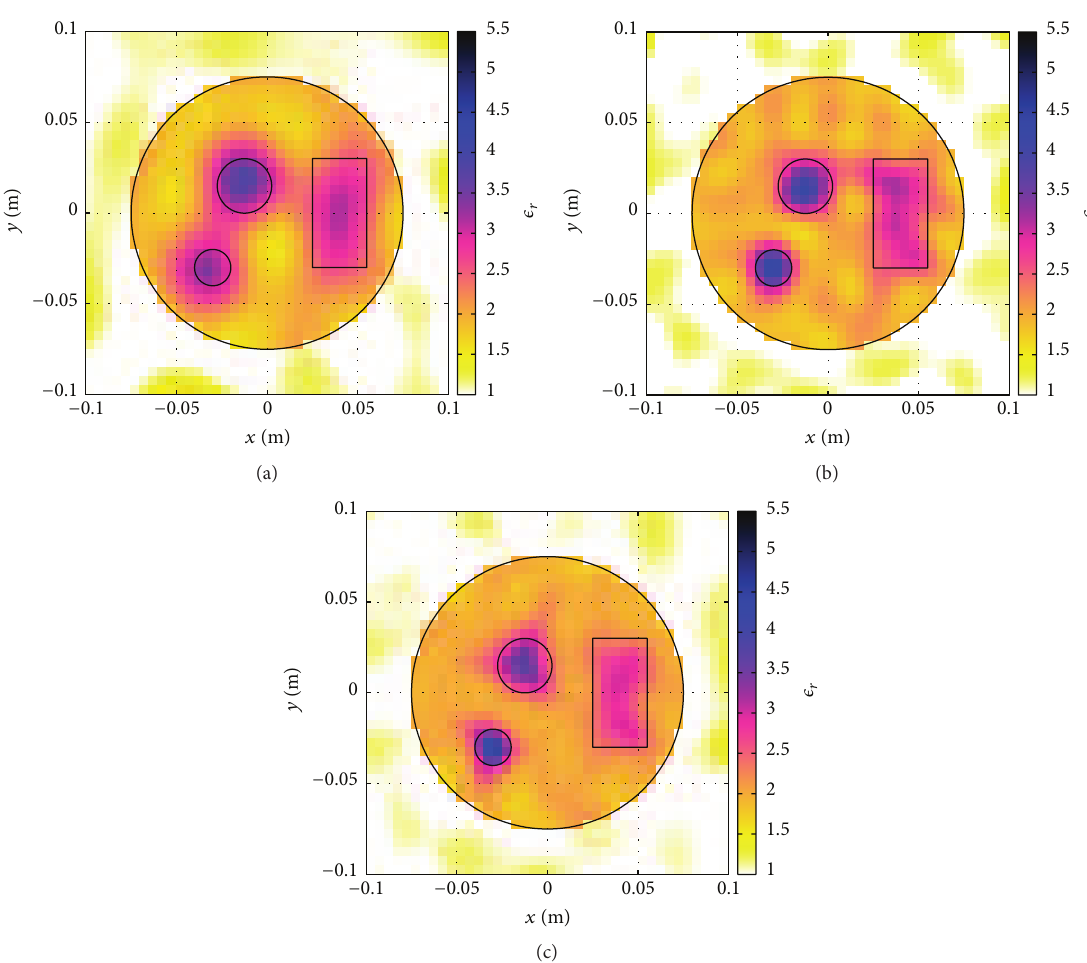
Figure 4: Reconstructed distributions of the relative dielectric permittivity of the investigation domain in different operating conditions, with 𝑆 = 10 and SNR = 20 dB: (a) 𝐹 = 1 , 𝑝 = 2.0 ; (b) 𝐹 = 3 , 𝑝 = 2.0 ; (c) 𝐹 = 3 , 𝑝 = 1.6